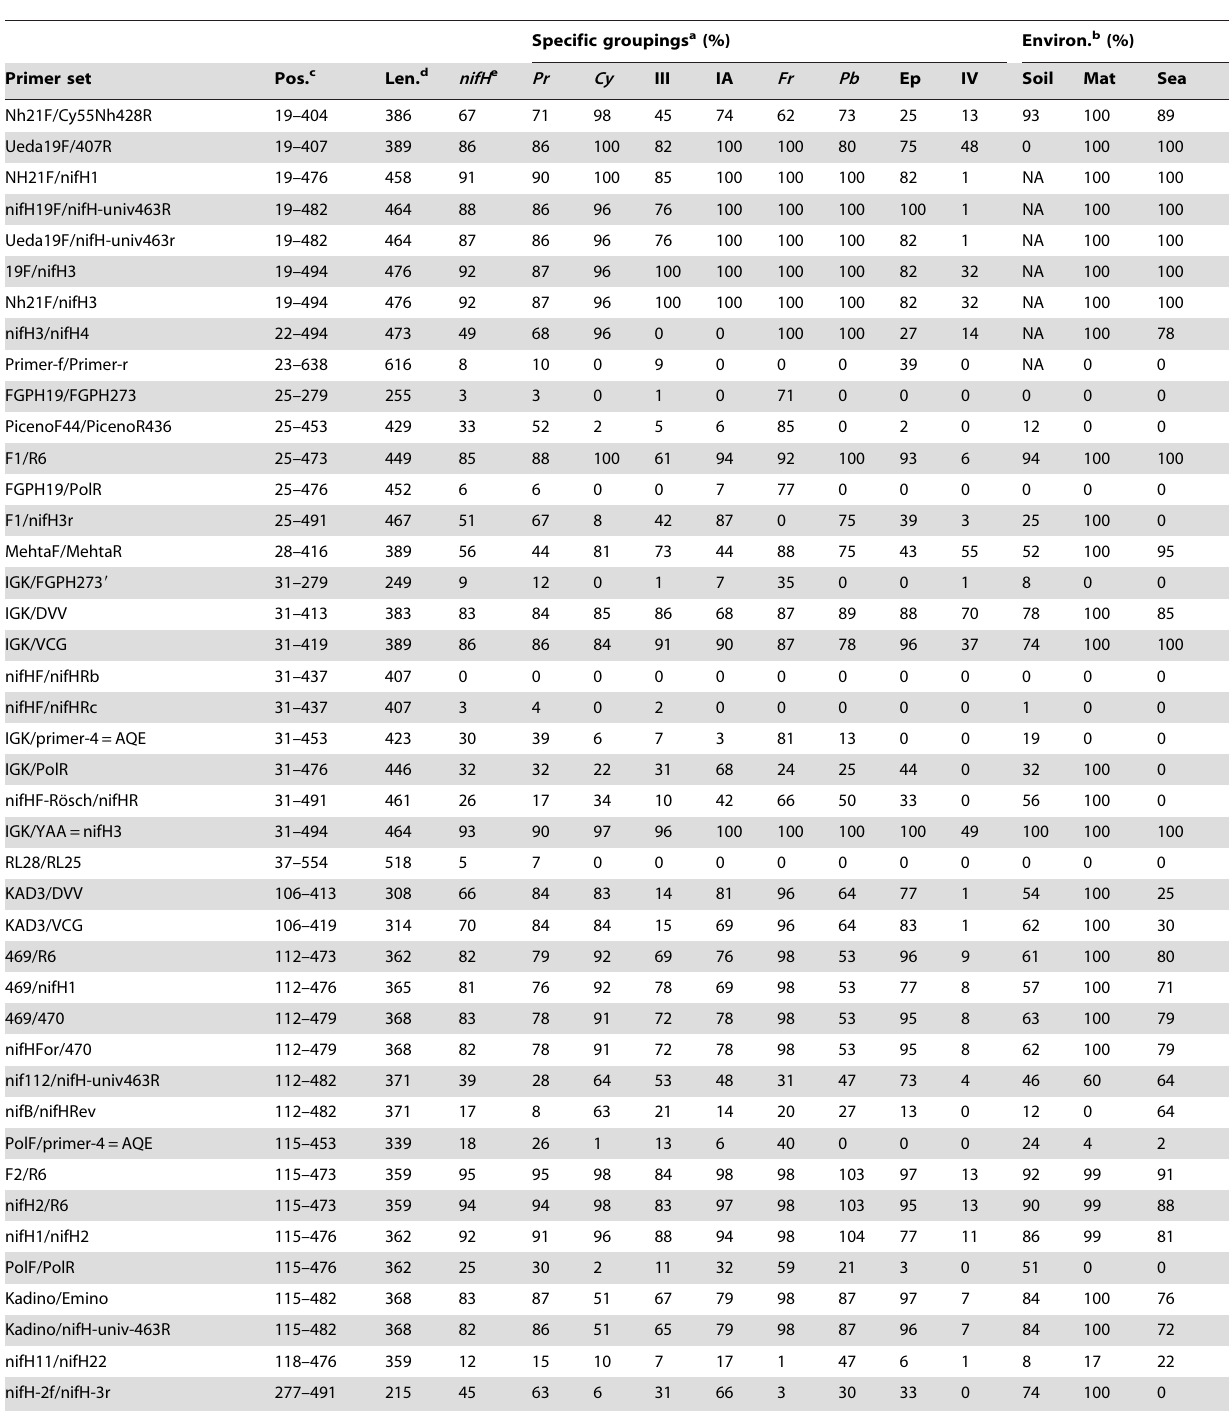
Table 4. Properties of universal primer pairs and their coverage for phylogenetic and environmental groupings in the nifH database.